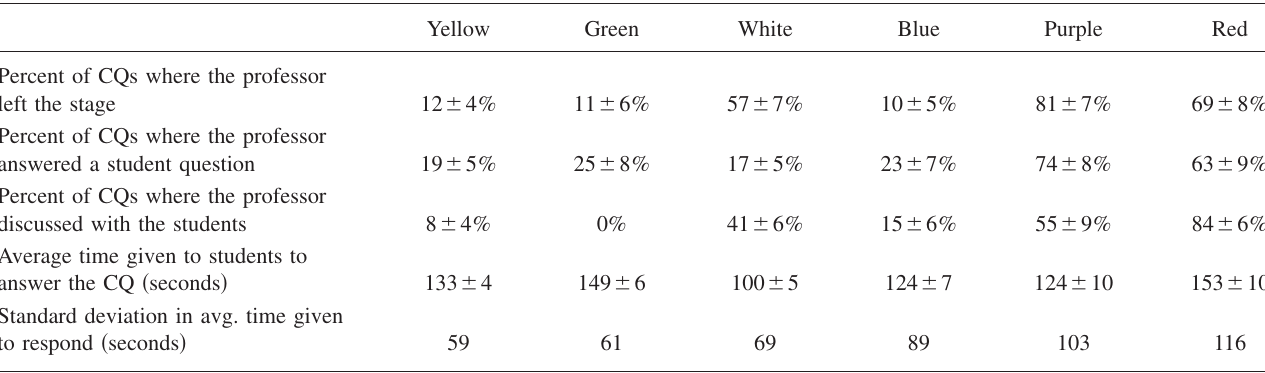
TABLE C. Characteristics of Practice-CQ Response Stage.